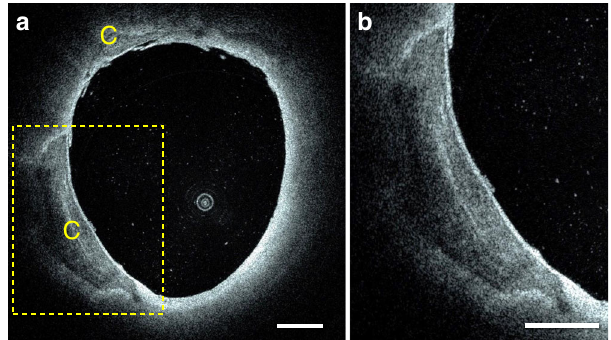
Fig. 8 Intracranial fi brocalci fi c plaques in a segment of an intradural vertebral artery. a Two fi brocalci fi c plaques are visible in the image. A smaller plaque with a calcium thickness between 100 and 300 µ m is located at 11 o ’ clock. A larger plaque with a calcium maximum thickness of 900 µ m is located in the bottom-left quadrant of the image. b Magni fi cation showing fi ne details of the plaque microstructure, including inner and outer boundaries. On HF-OCT, calci fi c tissue is characterized by a sharply demarcated area with a weaker and heterogeneous signal, resulting from a low optical backscattering and low absorption coef fi cients. Characterization of HF-OCT versus histopathology for imaging of fi brocalci fi c plaques was obtained from one intracranial artery specimen. Scale bars are equal to 1